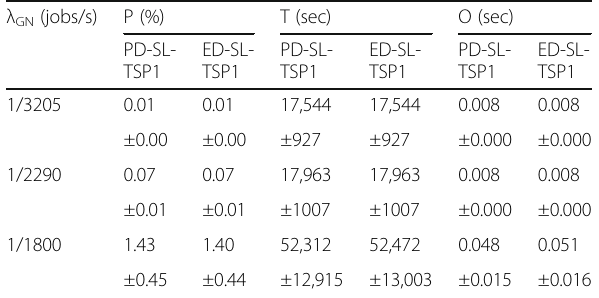
Table 3 Genome workload: effect of λ GN on P , T , and O λ GN (jobs/s)